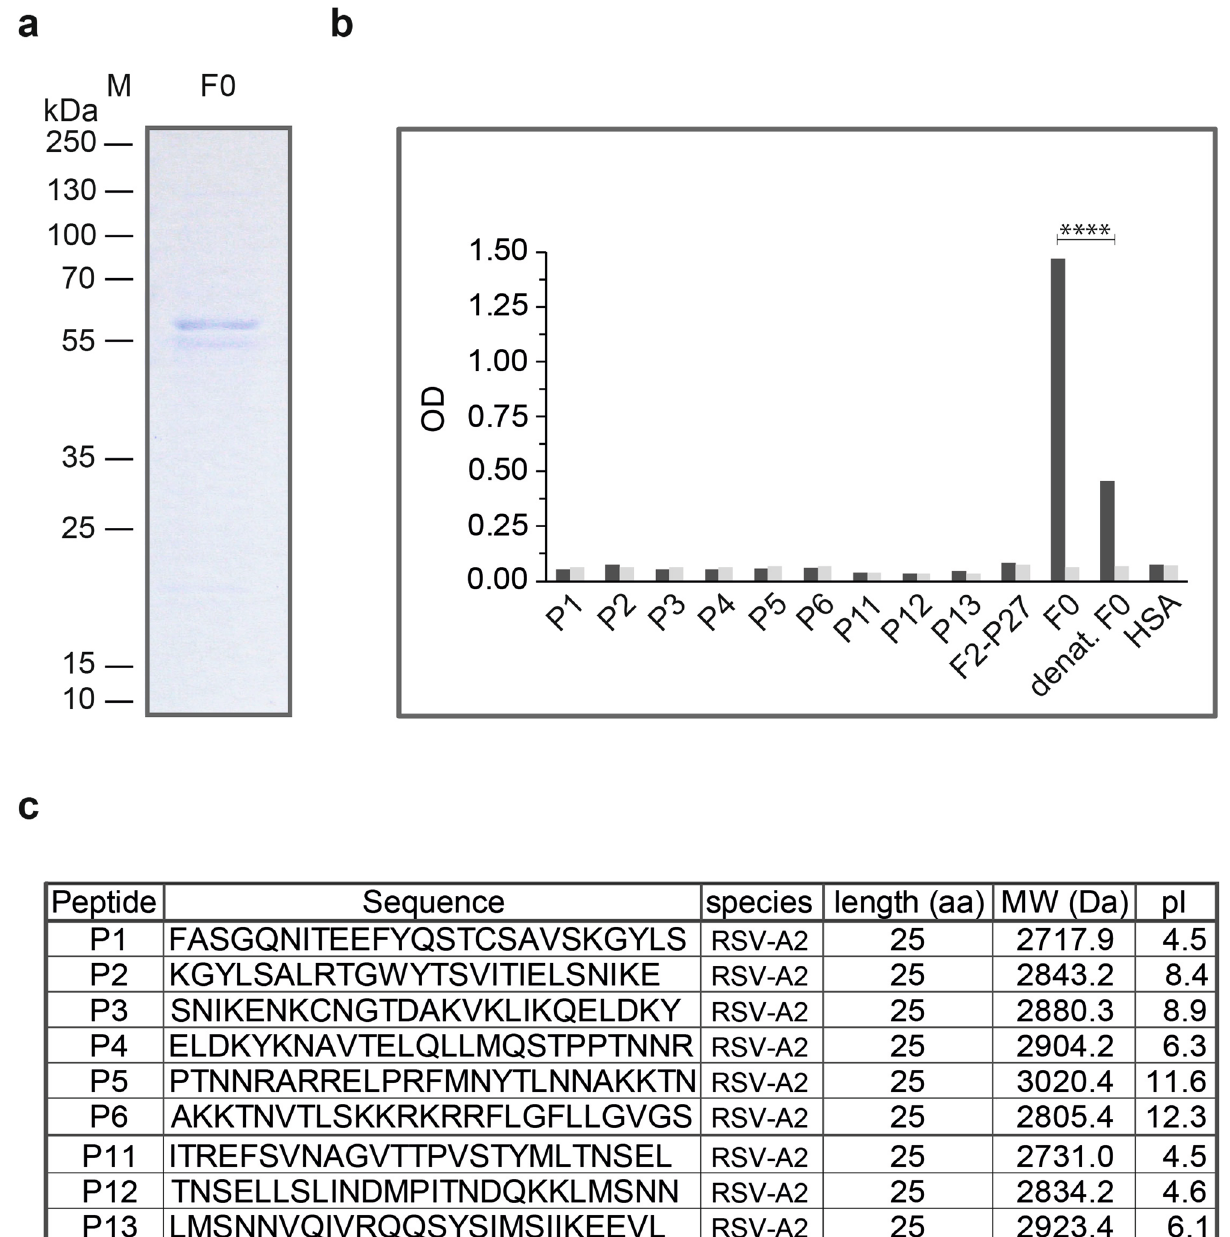
Figure 4. Characterization of recombinant F0 protein. ( a ) Coomassie brilliant blue-stained SDS-PAGE of recombinant F0 protein. Molecular weights (kDa) are indicated on the left margin. ( b ) Reactivity of palivizumab to native, denatured F0 and F0-derived peptides by ELISA. Optical density (OD) values (y-axis) correspond to bound human IgG antibodies, palivizumab (black bars) or buffer control (grey bars). Significant difference of palivizumab binding to native and denatured F0 is indicated (p < 0.0001; Mann–Whitney-U-test). ( c ) Characterization of synthetic peptides used (sequences, length, molecular weights, isoelectric points: